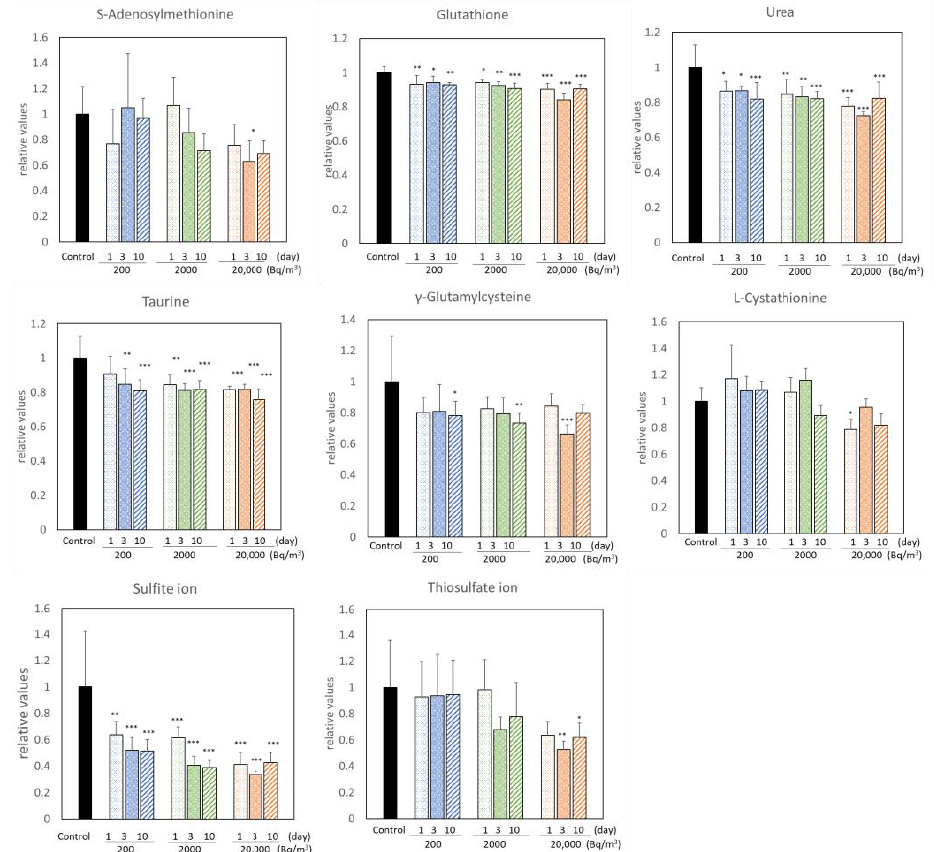
Figure 2. Metabolites significantly decreased by radon inhalation. The number of mice per experi- mental point is six. All quantitative data are presented as mean ± SD. * p < 0.05, ** p < 0.01, *** p < 0.001. vs. control.